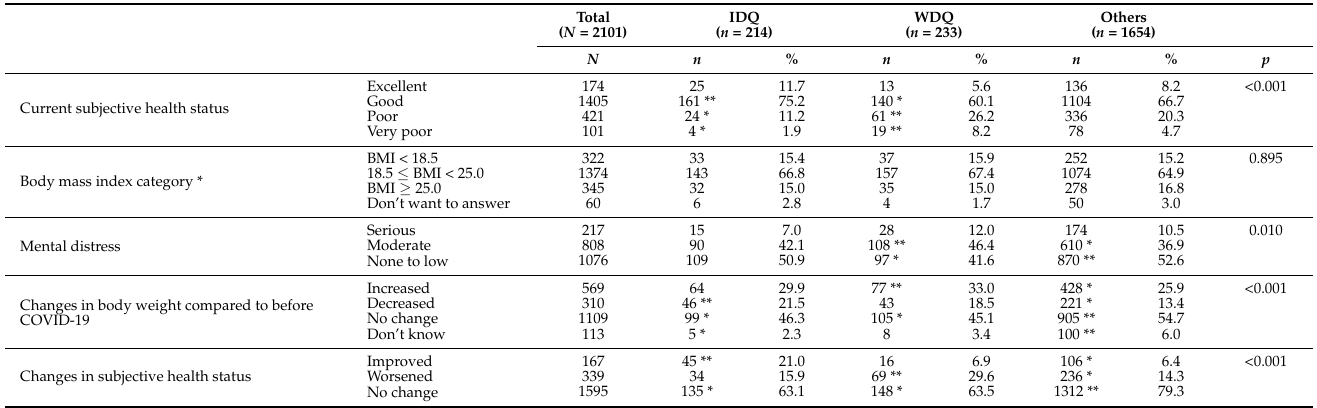
Table 2. Subjective health status and physical variables of participants according to changes in the diet quality.